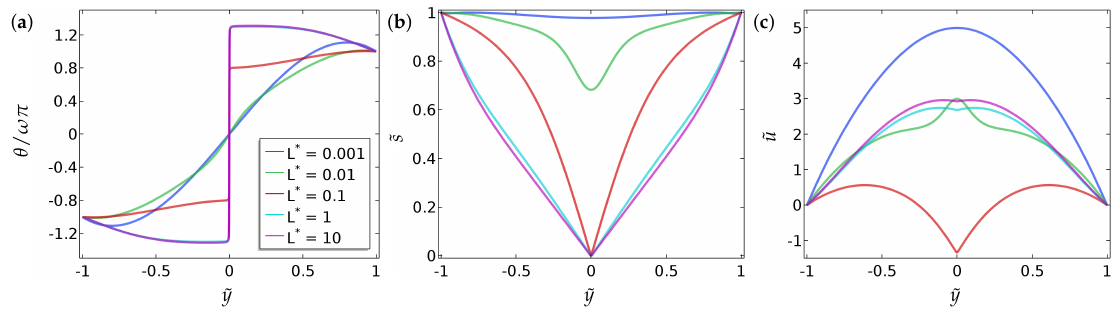
Figure 8. The effect of the parameter L ∗ on ( a ) the director orientation ( θ ) , ( b ) the order parameter ( ˜ s ) and ( c ) the velocity ( ˜ u ) , at equilibrium ( ˜ t = 10 ) , in the case of the symmetric boundary conditions for θ (Equation (15)). The values of the parameters used are ω = 1/2, L 2 = 1, ˜ p x = The legends of all the sub-figures are the same as in ( a ).